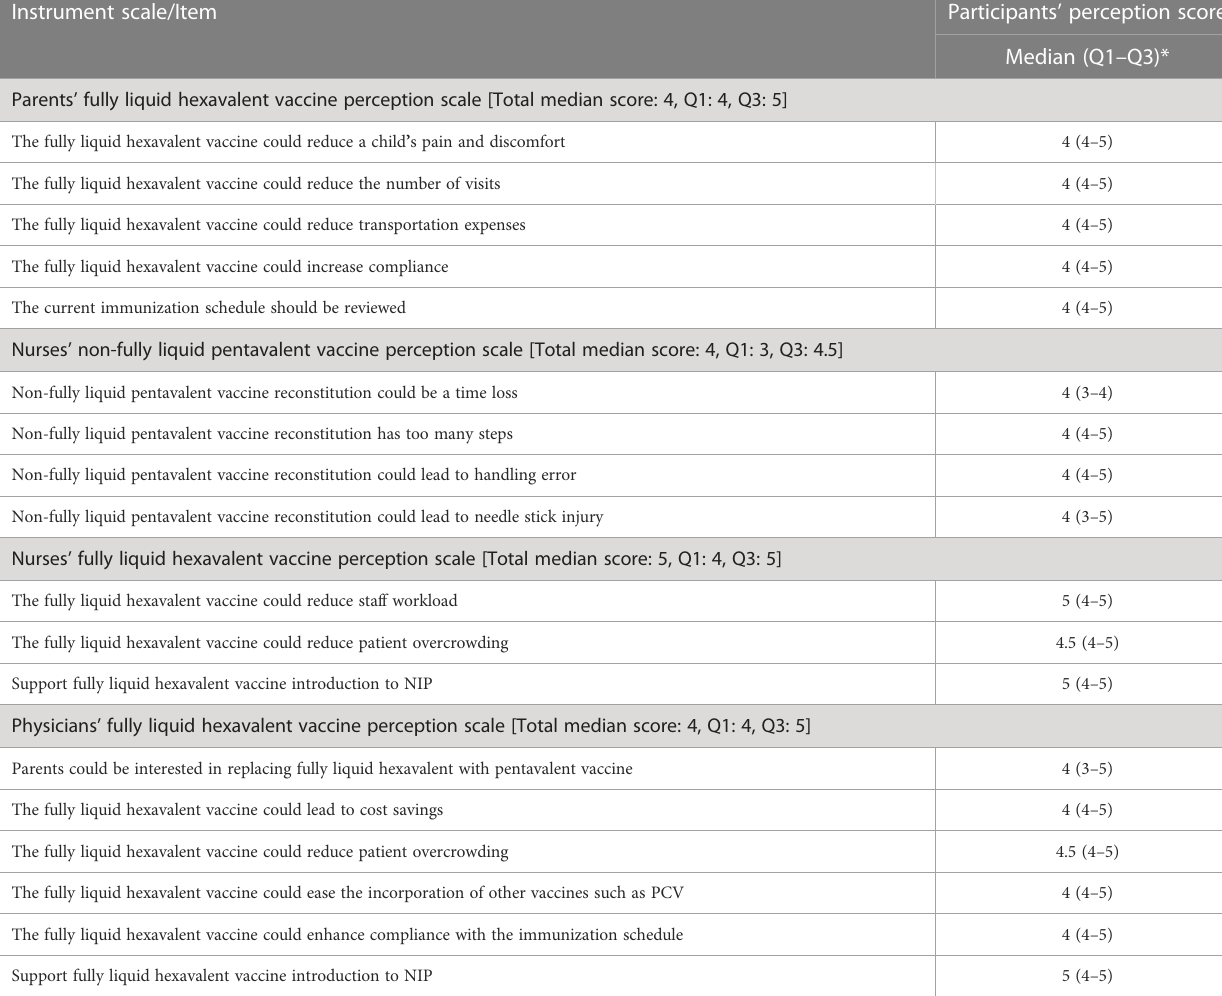
TABLE 1 Median score of participants ’ perception for each scale and its items. Instrument scale/Item